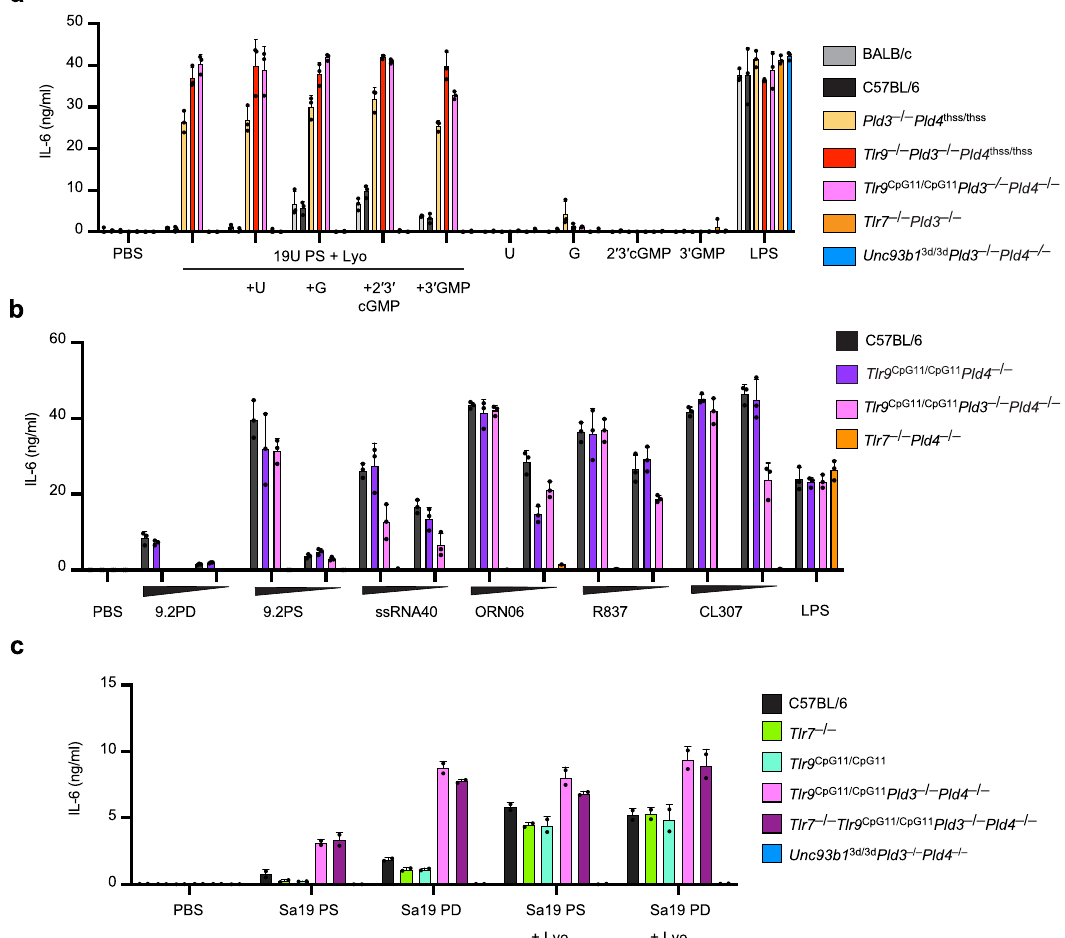
Fig. 6 Analysis of RNA sensing by TLR7 and TLR13 in cells lacking PLD3 and PLD4. GM-CSF-elicited DCs of the indicated genotypes were challenged